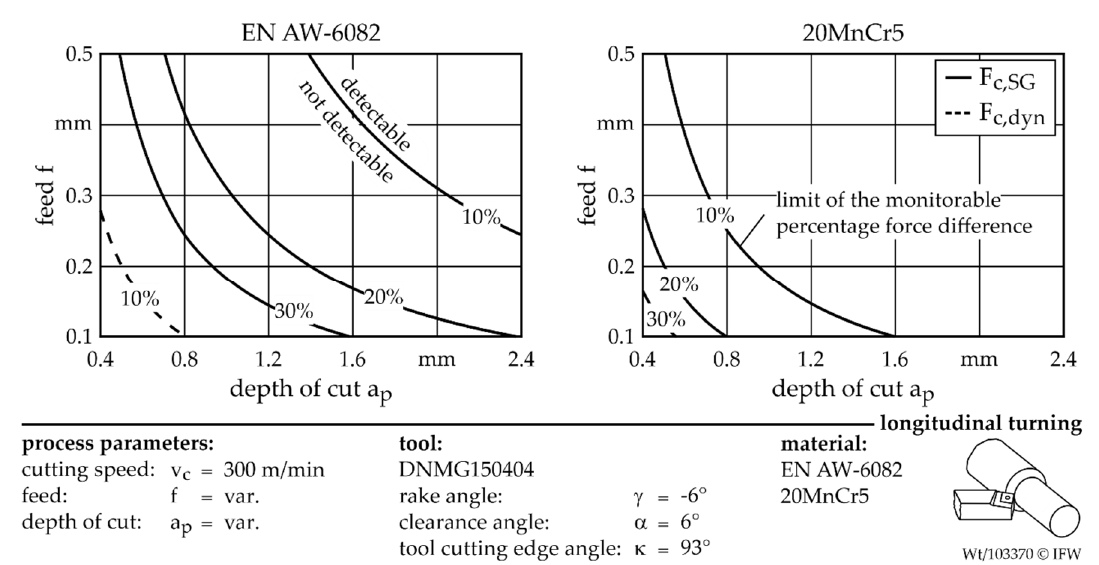
Figure 6. Representation of the monitorable percentage increase of the cutting force for EN AW-6082 and 20MnCr5 based on the feeling turret and dynamometer.